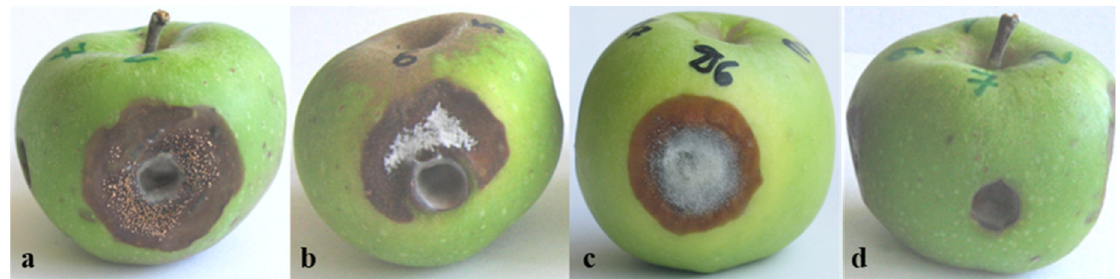
Figure 5. Pathogenicity tests on green apples, conducted according to Talhinhas et al., 2008 [51], performed with different Colletotrichum species: ( a ) C. nymphaeae (Ca13-1); ( b ) C. salicis (Ca44-1); ( c ) C. cigarro (CgD6-1); ( d ) C. coccodes (Cc7-1). Designations of the isolates used for inoculation are shown in parentheses.